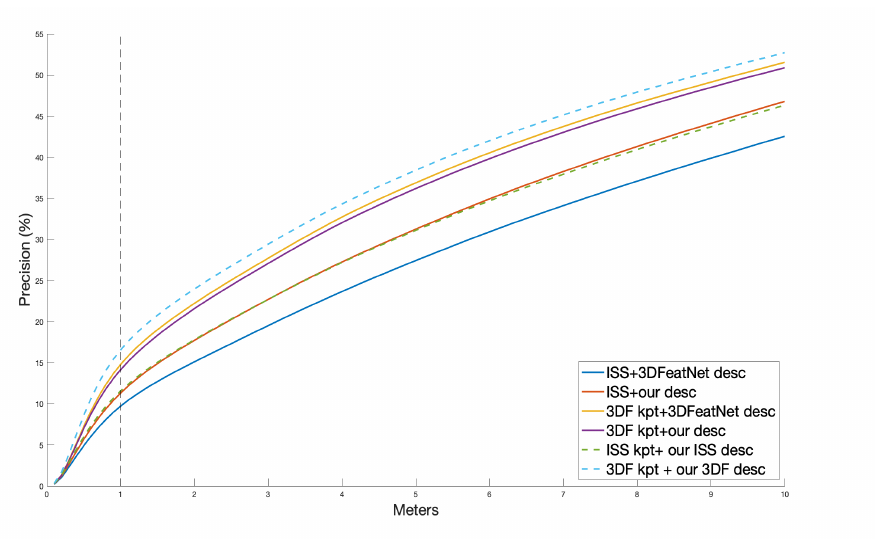
Figure 3. Precision plot for distance between nearest neighbor point and the ground truth